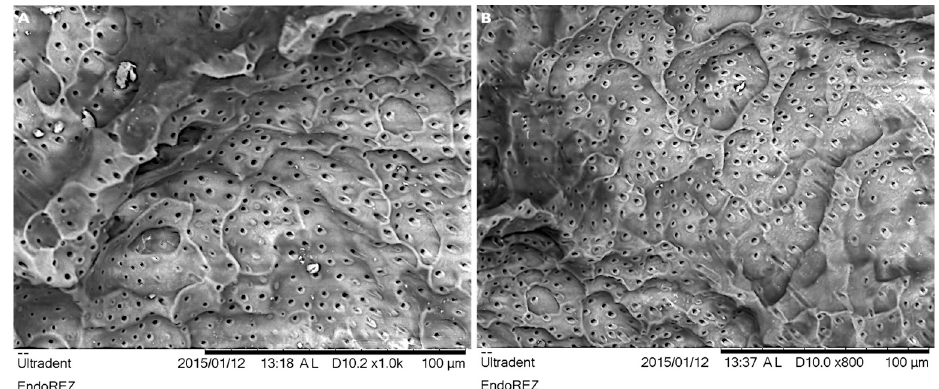
Figure 2. The typical surface profile of the resorbed root of primary teeth with lacune-type dentin defects at ×1000 ( A ) and ×800 ( B ) magnification.